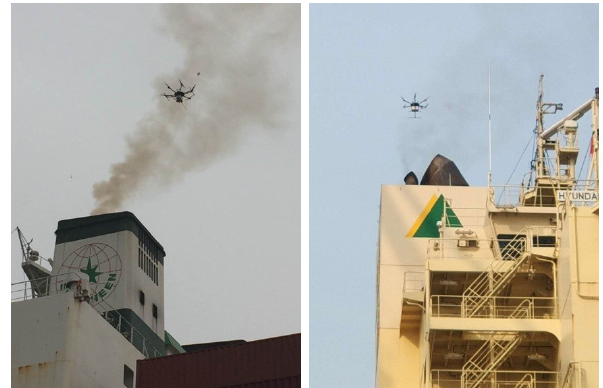
Figure 4. Photographs showing the flight of the UAV during mea- surements. The UAV platform was flown close to the funnel of ship for collecting exhaust gas and detection at Waigaoqiao